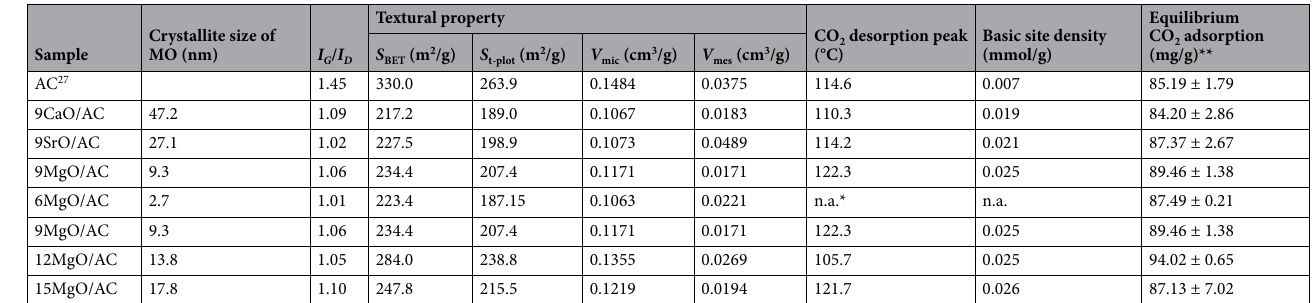
Table 1. Effect of metal oxide types and loading on textural properties and basic site density. * Not analyzed. ** Equilibrium adsorption in the presence of 50 mol% CO 2 in the biohydrogen at a total flow rate of 100 mL/ min, 25 °C and 1